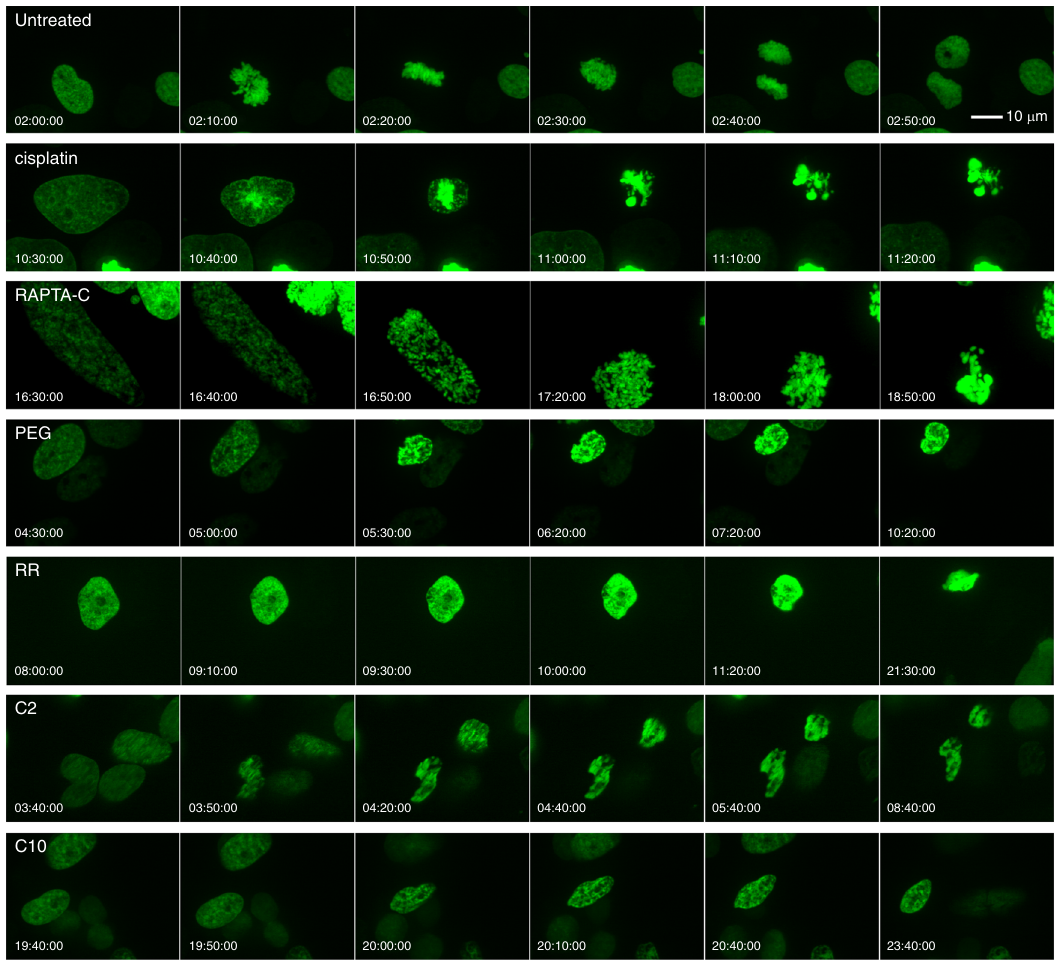
Fig. 5 Live fl uorescence imaging of drug- and binuclear-treated cells. Nuclear chromatin is visible by virtue of the incorporated H2B-EGFP histone fusion protein. Montages correspond to extractions from the 24 h imaging sequences (Supplementary Movies 1 – 7; times shown at bottom for each